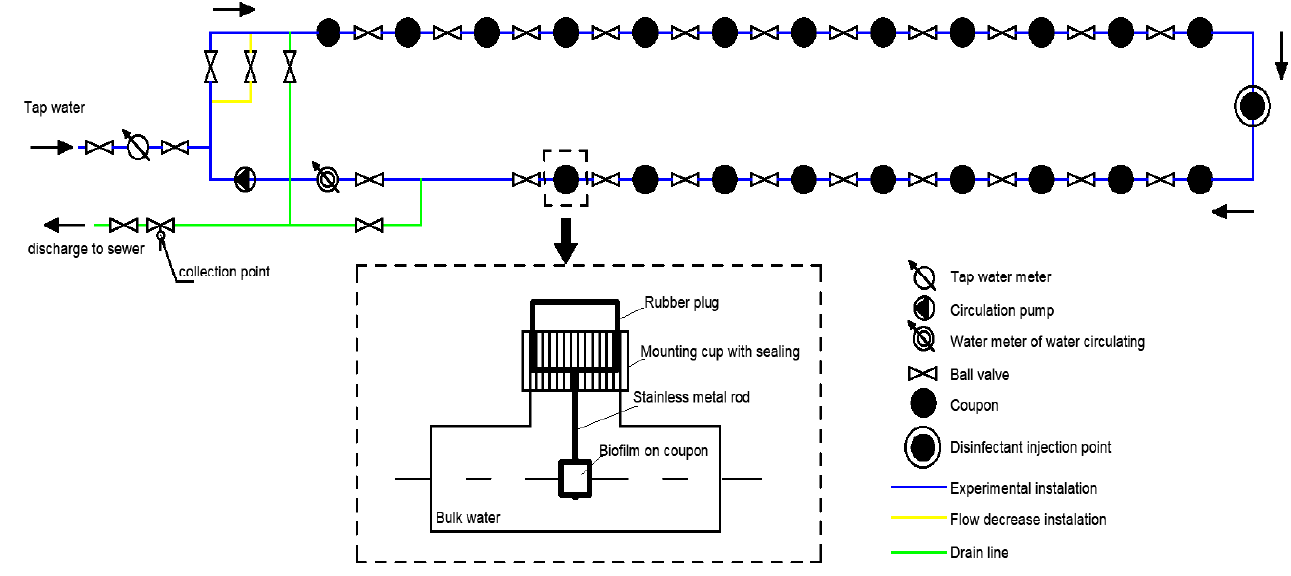
Figure 1. The scheme of an experimental installation.